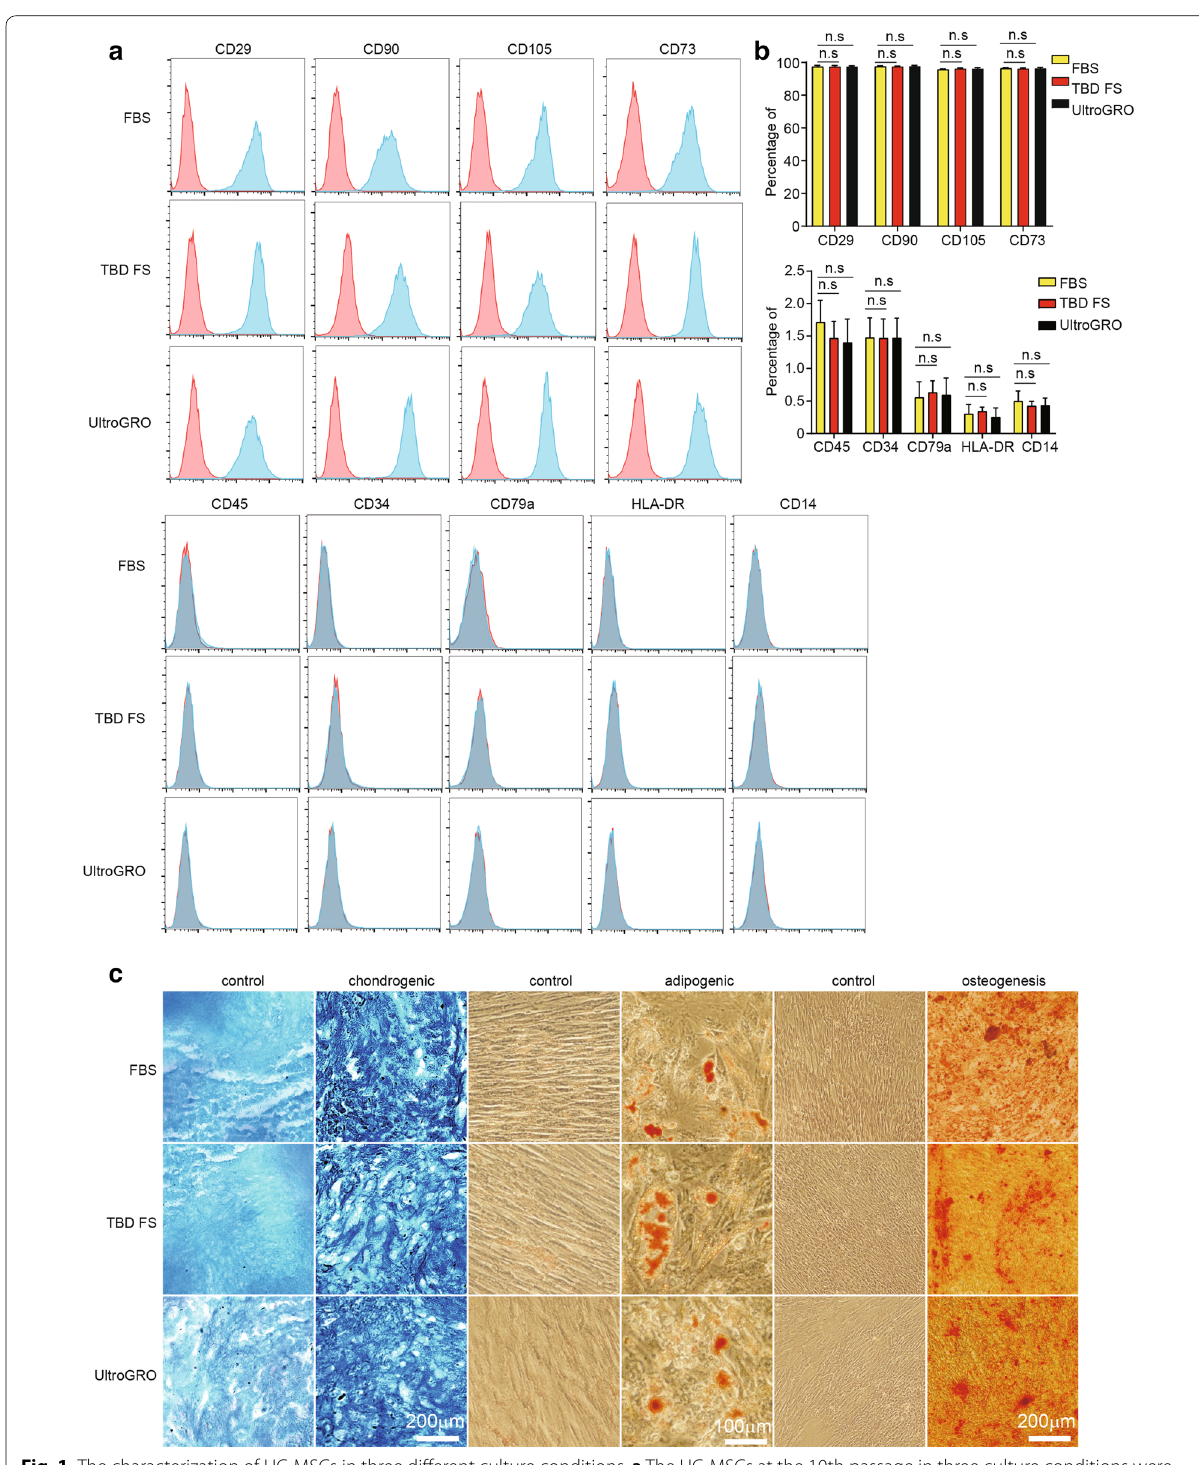
Fig. 1 The characterization of UC-MSCs in three different culture conditions. a The UC-MSCs at the 10th passage in three culture conditions were positive for CD29, CD90, CD105, and CD73, and were negative for CD45, CD34, CD79a, HLA-DR, and CD14. b The flow cytometry statistics of stem cell markers in three culture conditions. c The UC-MSCs at the 10th passage in three culture conditions were stained with Alcian blue, oil red O, and Alizarin Red S, respectively. For all experiments, n 3 healthy donors/group, and data shown are mean = ±